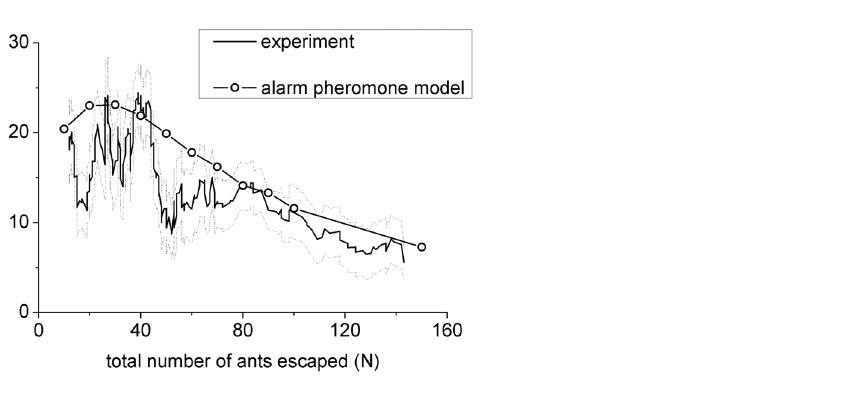
Fig. 5. The comparison of the alarm pheromone model results and the experiment outcomes from Fig.2. The solid dots (simulation results) are averaged over 10000 runs with the parameters p 0 ~ 1 = 5 and t fo ~ 30 seconds . The model simulation agrees well with the experiment outcomes with the initial increase and then following decrease.